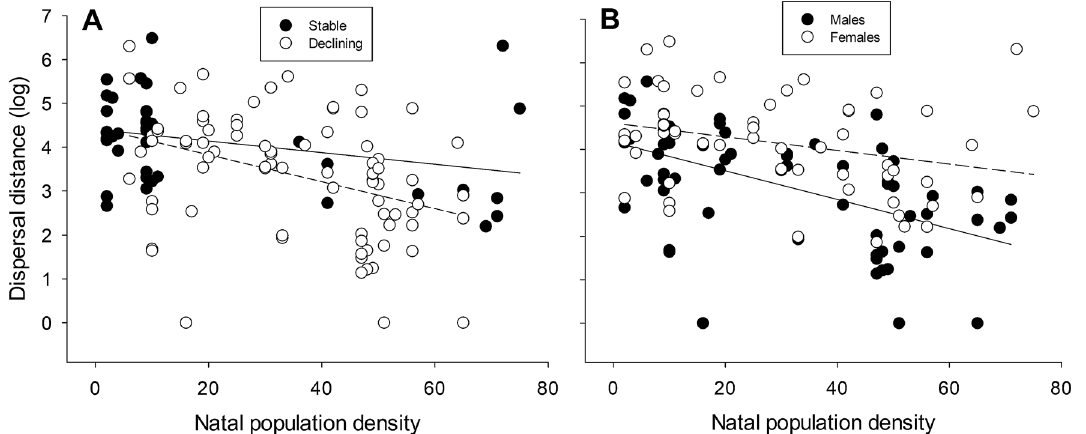
Figure 3. ( A ) Relationship between dispersal distance (log scale) and natal population density (number of breeding pairs in a buffer of 48 km around the natal nest). Trends from stable/increasing populations (filled circles, solid line) and decreasing populations (open circles, dashed line) are shown separately. ( B ) Relationship between dispersal distance (log scale) and natal population density (number of breeding pairs in a buffer of 48 km around the natal nest). The solid and the dashed line correspond to males and females